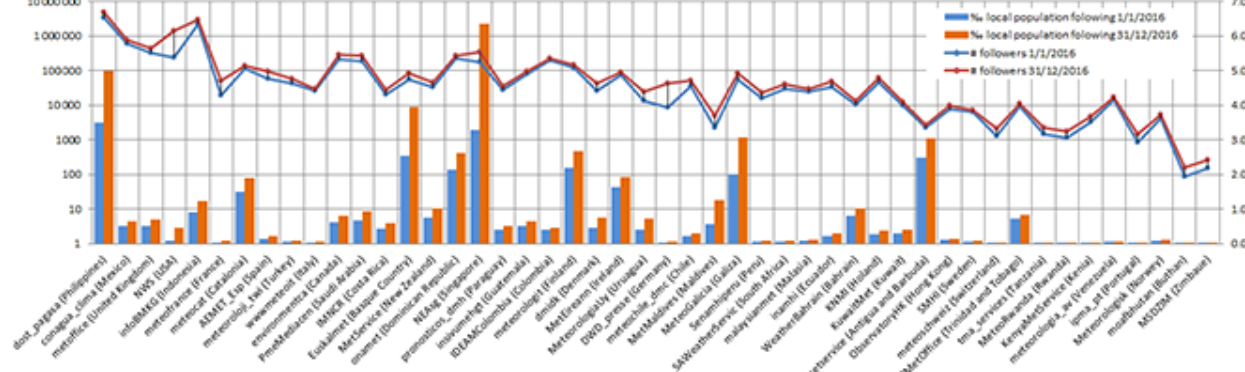
Figure 4. Followers analysis showing number (#) of followers (left with logarithmic scale) and proportion of local population following (right) pre-2016 (blue) and at the end of 2016